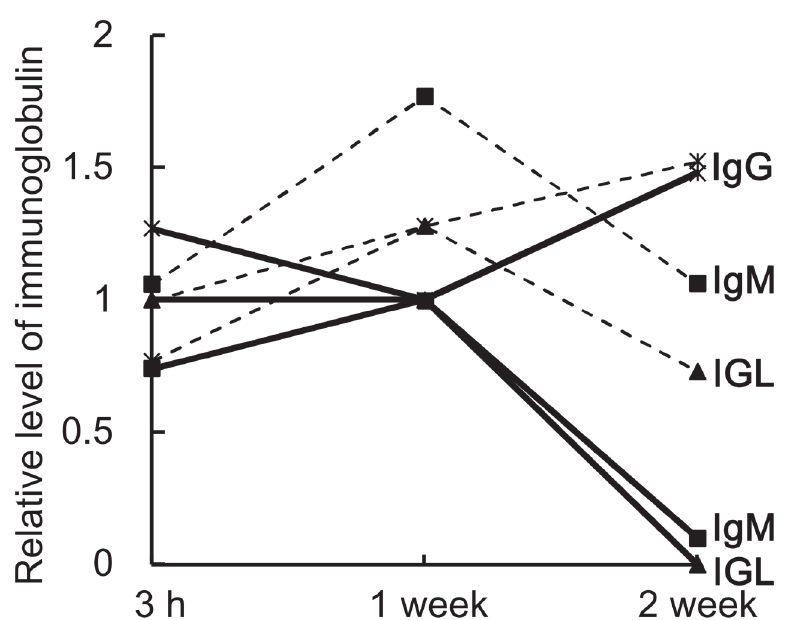
Figure 3- Relative levels (fold) of immunoglobulin M (IgM), immunoglobulin G (IgG) and immunoglobulin light chain (IGL) determined through peptide analysis in extraction only (EO) groups (dotted lines) and extraction with socket preservation (SP) groups (solid lines). Whereas IgM (lines with solid squares) and IGL (lines with solid triangles) appeared to peak 1 week after tooth extraction, IgG (lines with asterisks) levels were higher after 2 weeks in both groups (EO and SP group). Immunoglobulins were generally higher in EO groups than the SP